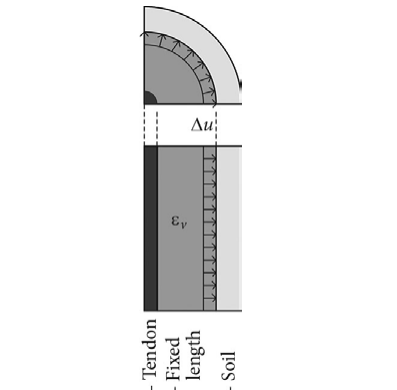
Fig. 8. Confidence ellipse of regression coefficients for the WLSM